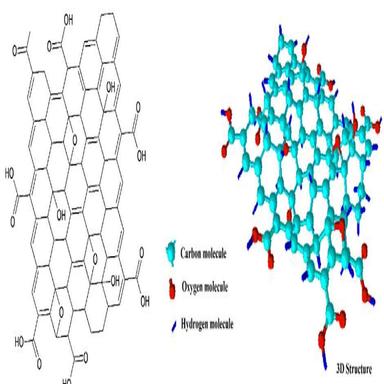
The structure of Graphene Oxide (GO).